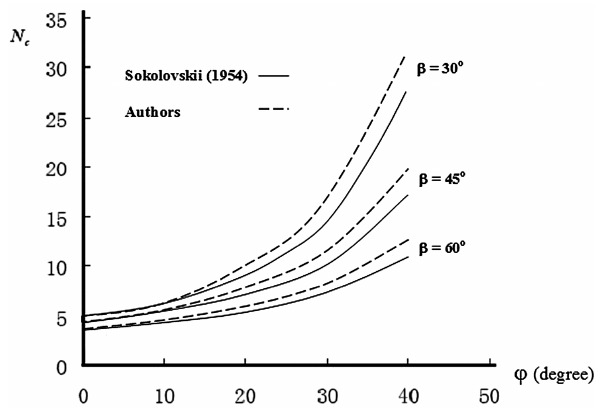
Figure 4. Comparison of N c values between Sokolovskii method and authors’ method.